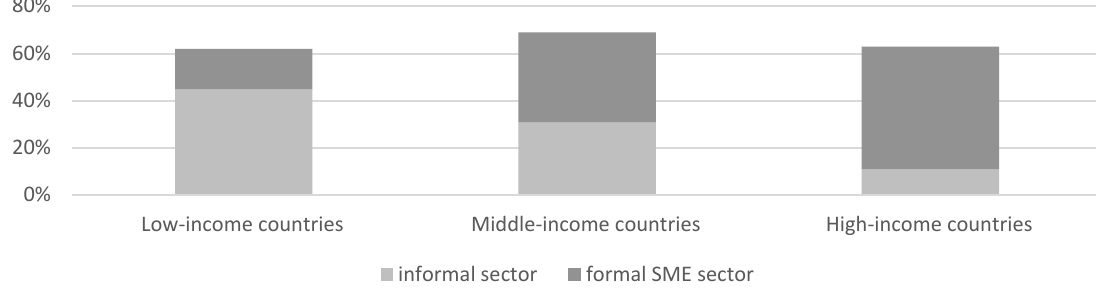
Figure 1. Contribution of SMEs to GDP (middle values) (Growing the global economy through